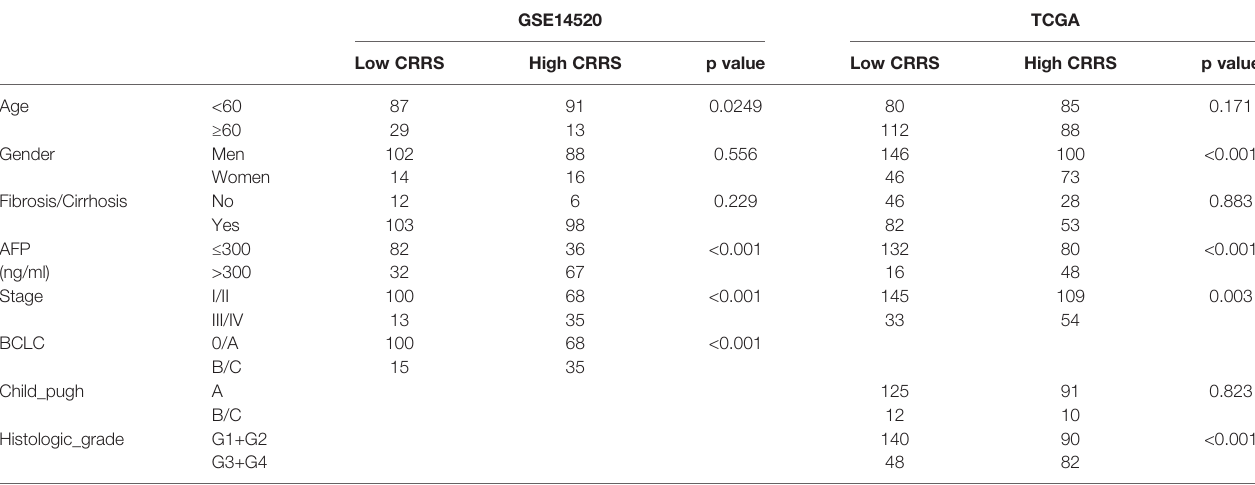
TABLE 1 | Relationships between cuproptosis-related risk score (CRRS) and clinicopathological features of clinicopathological features of hepatocellular carcinoma (HCC) patients.